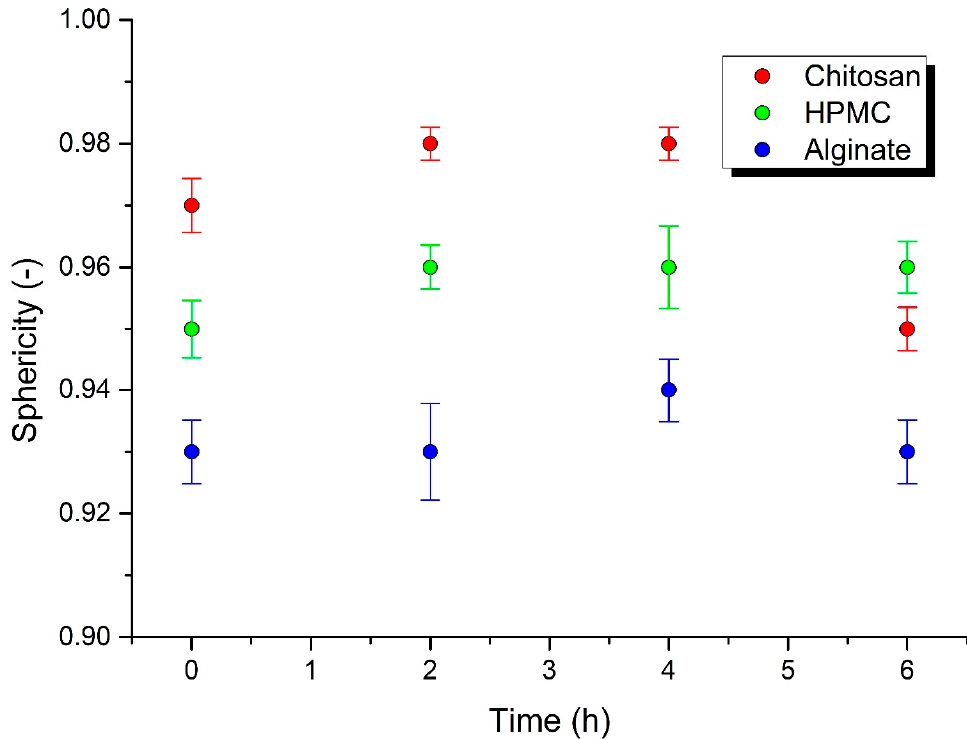
Figure 1. Sphericity change during dissolution testing.